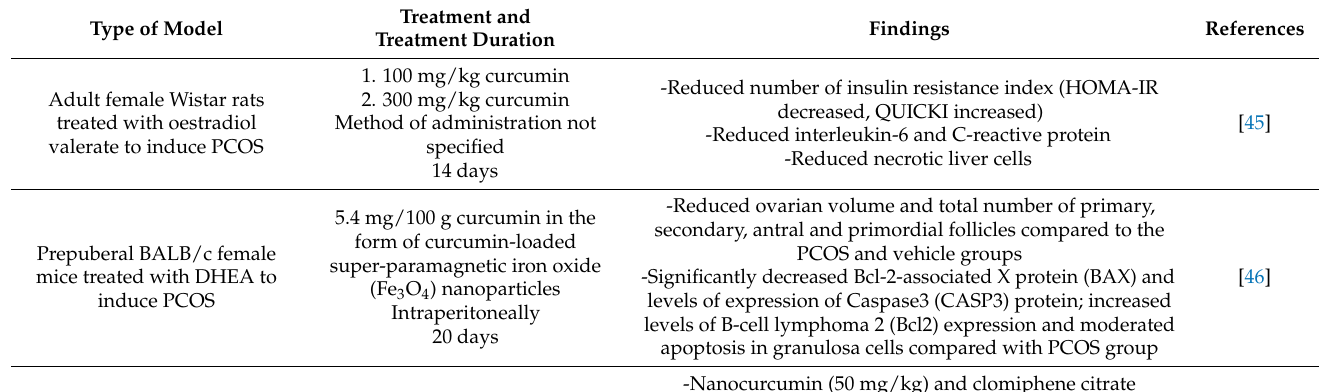
Table 2. Summary of the effects of curcumin on PCOS in